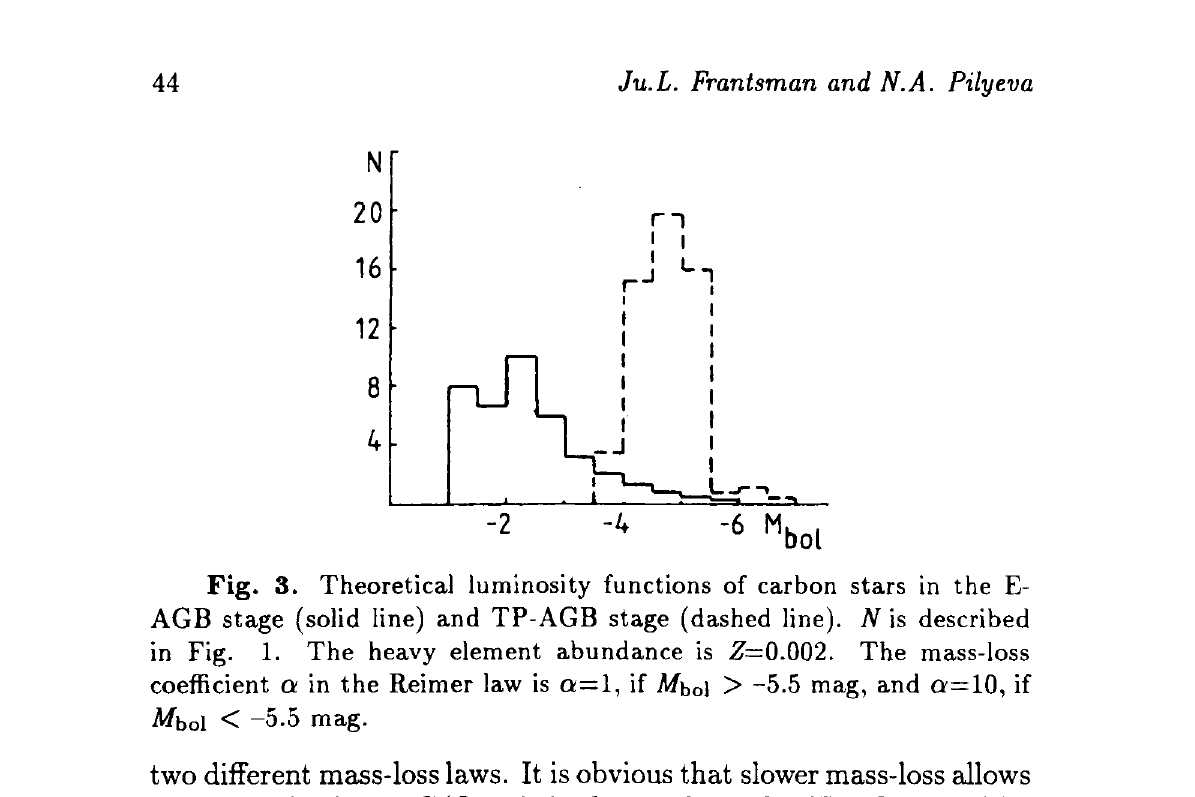
Fig. 3. Theoretical luminosity functions of carbon stars in the E- AGB stage (solid line) and TP-AGB stage (dashed line). N is described in Fig. 1. The heavy element abundance is Z— 0.002. The mass-loss coefficient a in the Reimer law is a = l, if A/bol > -5.5 mag, and a=10, if M>ol < -5.5